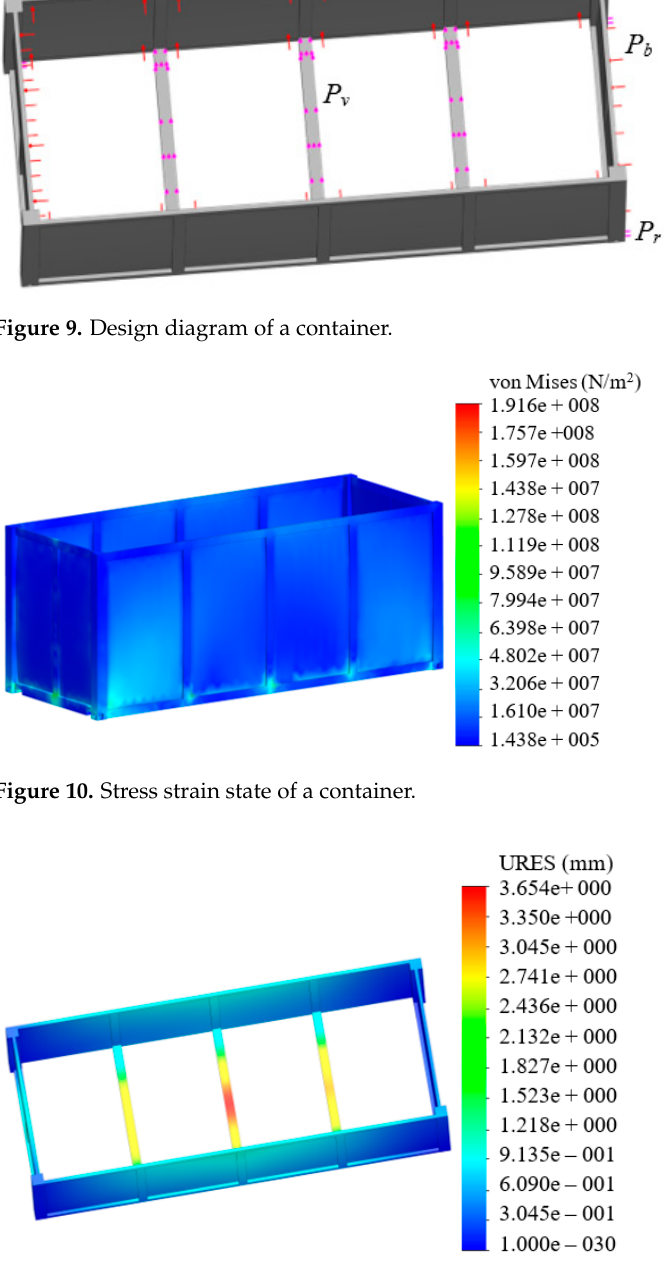
Figure 9. Design diagram of a container.